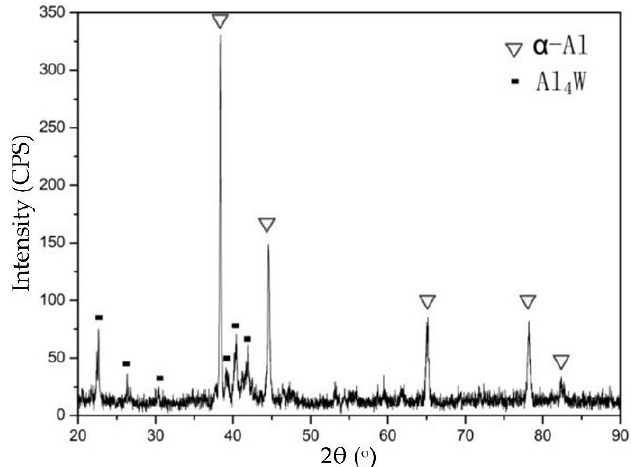
Figure 9. XRD analysis results of the cladding layer prepared with 60 wt.% WC powders.